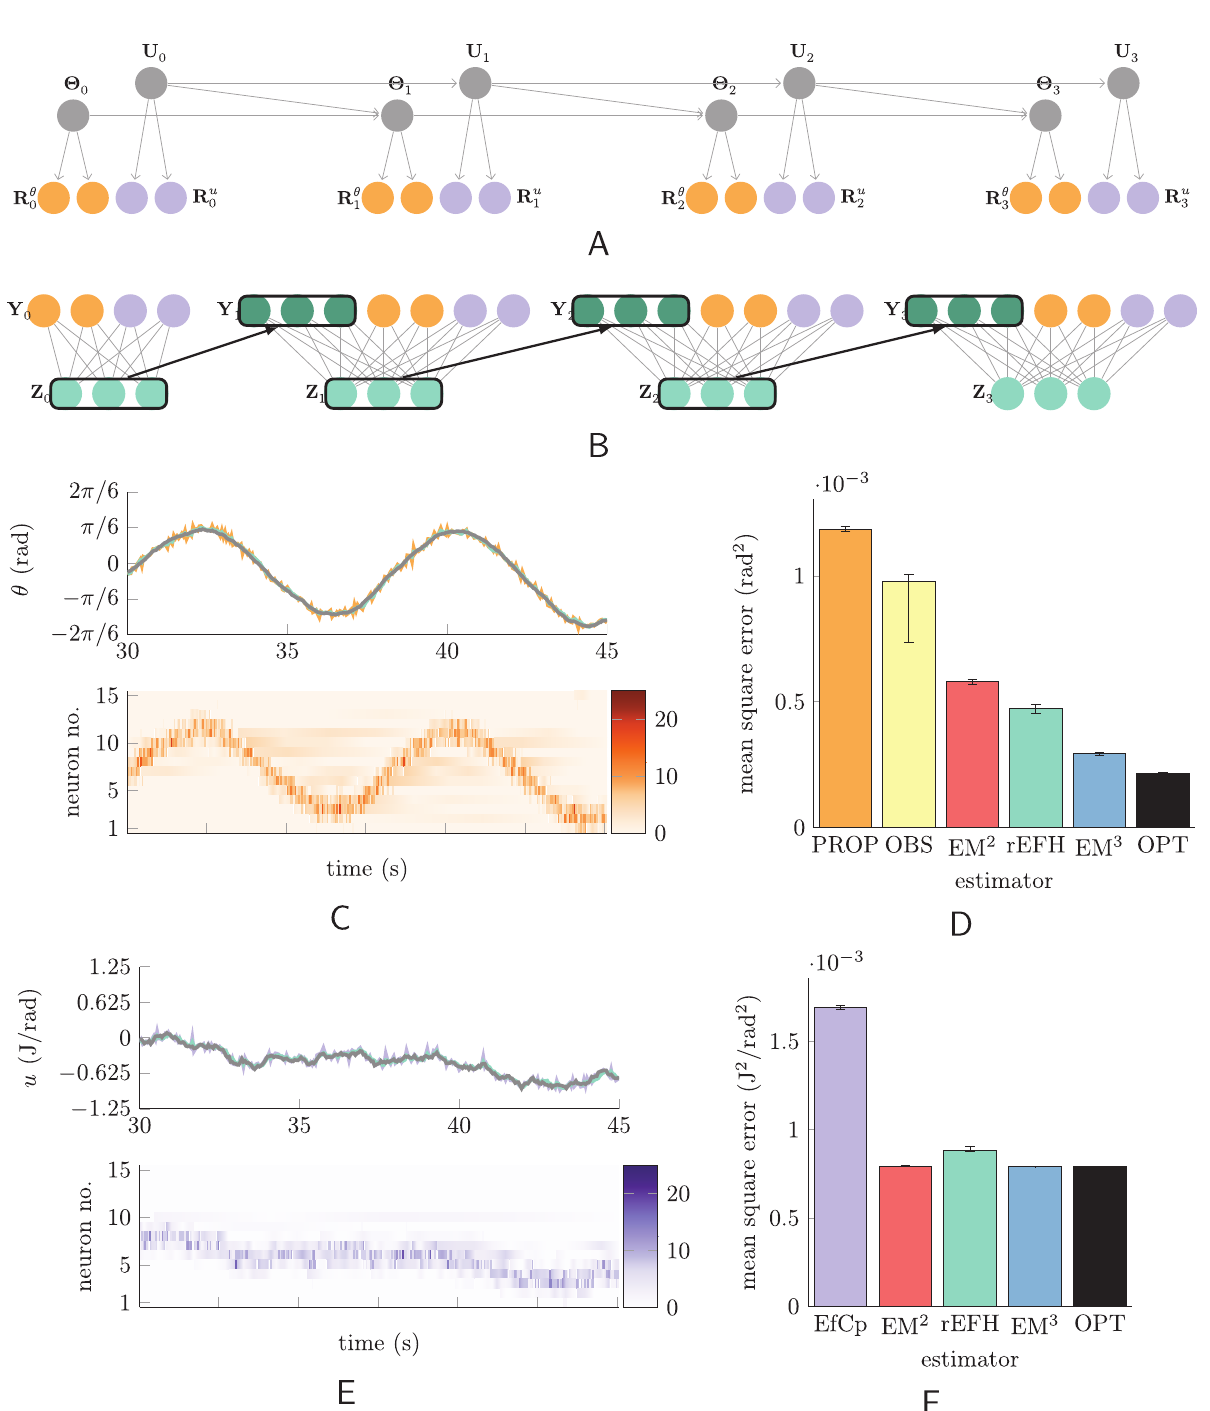
Fig 3. Dynamical system with efference copy. A reprise of Fig 1 for the controlled system. The evolution is now third-order, since the control signal is (close to) a random walk. (A) Angle (but not angular velocity) and the control signal are each noisily reported by populations of neurons (orange and purple; two of the fifteen neurons are depicted). (B) The training data for this harmonium at each time step are these two populations, and recurrent activity from the hidden units. (C) (Top) Fifteen seconds of a typical trajectory (black) and the trajectory decoded from the sensory population (orange), and from the hidden units (turquoise). The influence of the control can be seen in the (mildly) increasing amplitude of the oscillation. (Bottom) The activity of the fifteen sensory neurons is reported as a heat map. (D) Error statistics for joint-angle decoding under different models (see text). (E) The same as in (C), but the neurons carry “ efference copy ” rather than sensory information. (F) Error statistics for control-signal decoding under different models (see text). Error bars mark the first and third quartile across twelve de novo trained and tested networks of each type.